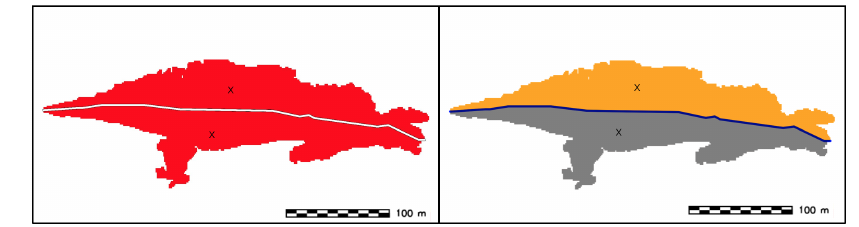
Figure 23. Identification of dune’s sides: stoss (colored in gray) and lee (colored in yellow).